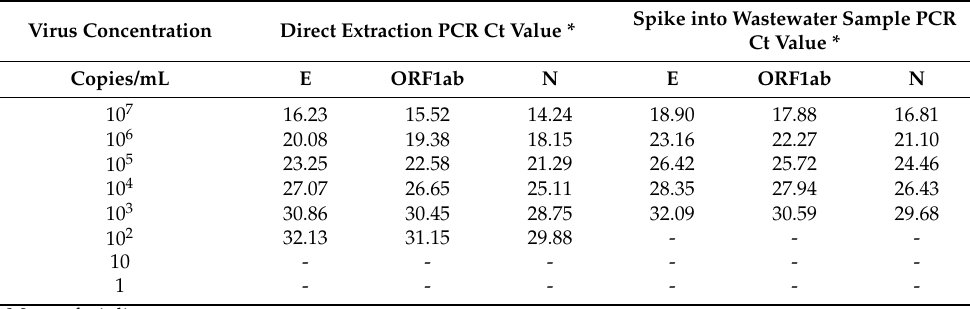
Table 2. SARS-CoV-2 RT-PCR results of Delta virus isolate and wastewater samples spiked with Delta virus separated at eight dilutions from 1 to 10 7 copies/mL. Virus Concentration Direct Extraction PCR Ct Value